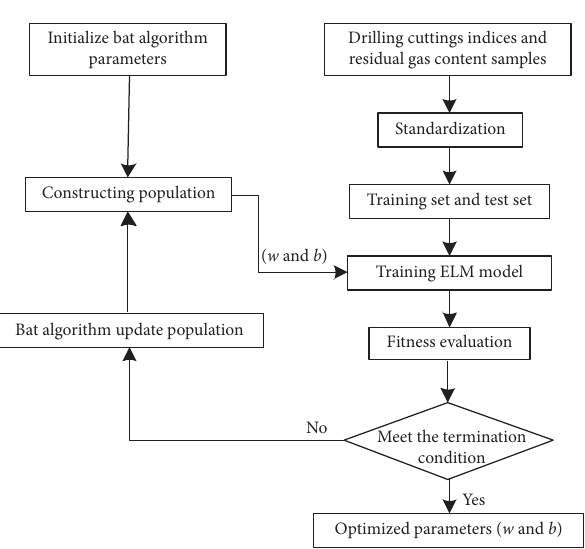
Figure 4: Flow chart of BA-ELM